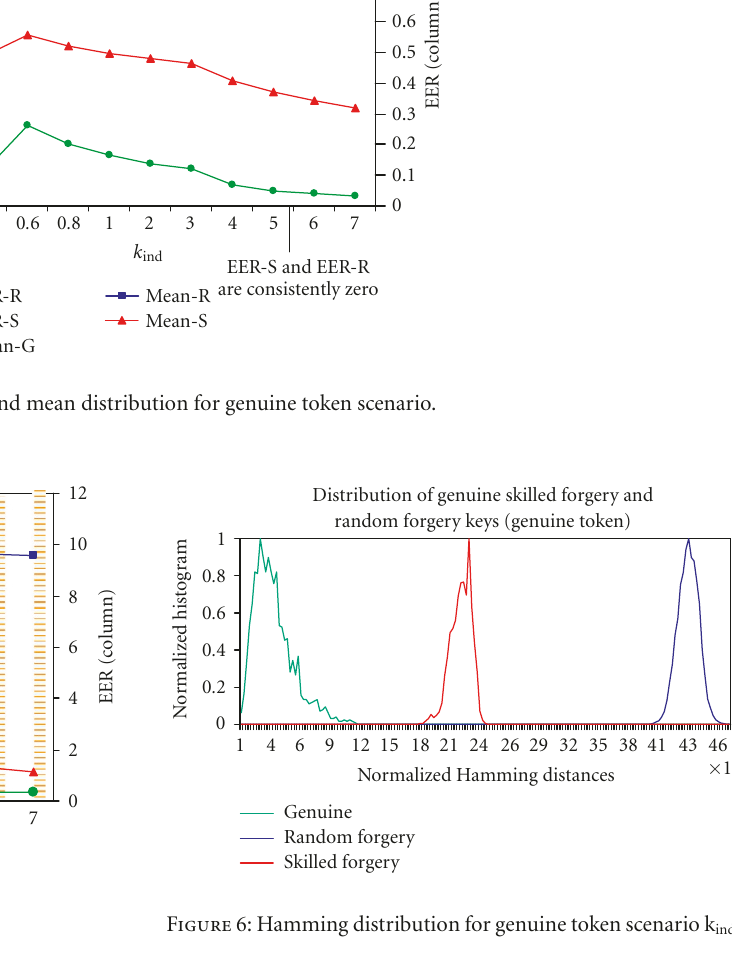
Figure 4: EER and mean distribution for stolen token scenario.